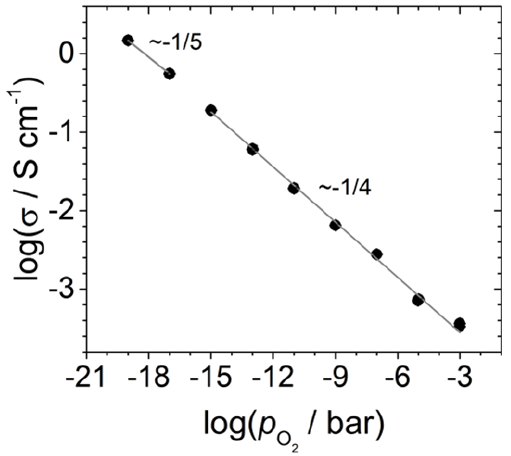
Figure 7. Electrical conductivity of a TiO 2 - δ thin film at 850 ◦ C in dependence of oxygen partial pressure.